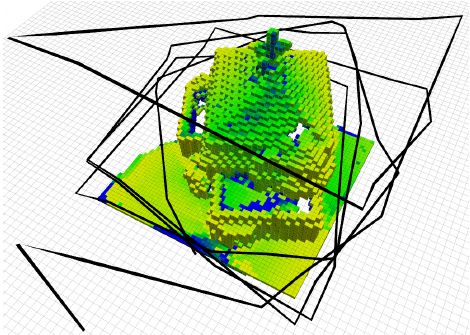
Figure 5. Result of the algorithm execution after 40 computed viewpoints. The black line represents the trajectory and the model in the center is the result of the reconstruction. The voxels are colored according to their uncertainty.